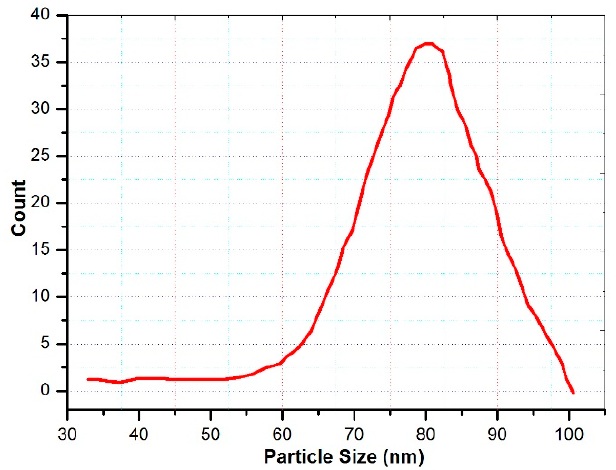
Figure 8. Histogram of the particle size distribution of ZnO nanoparticles.